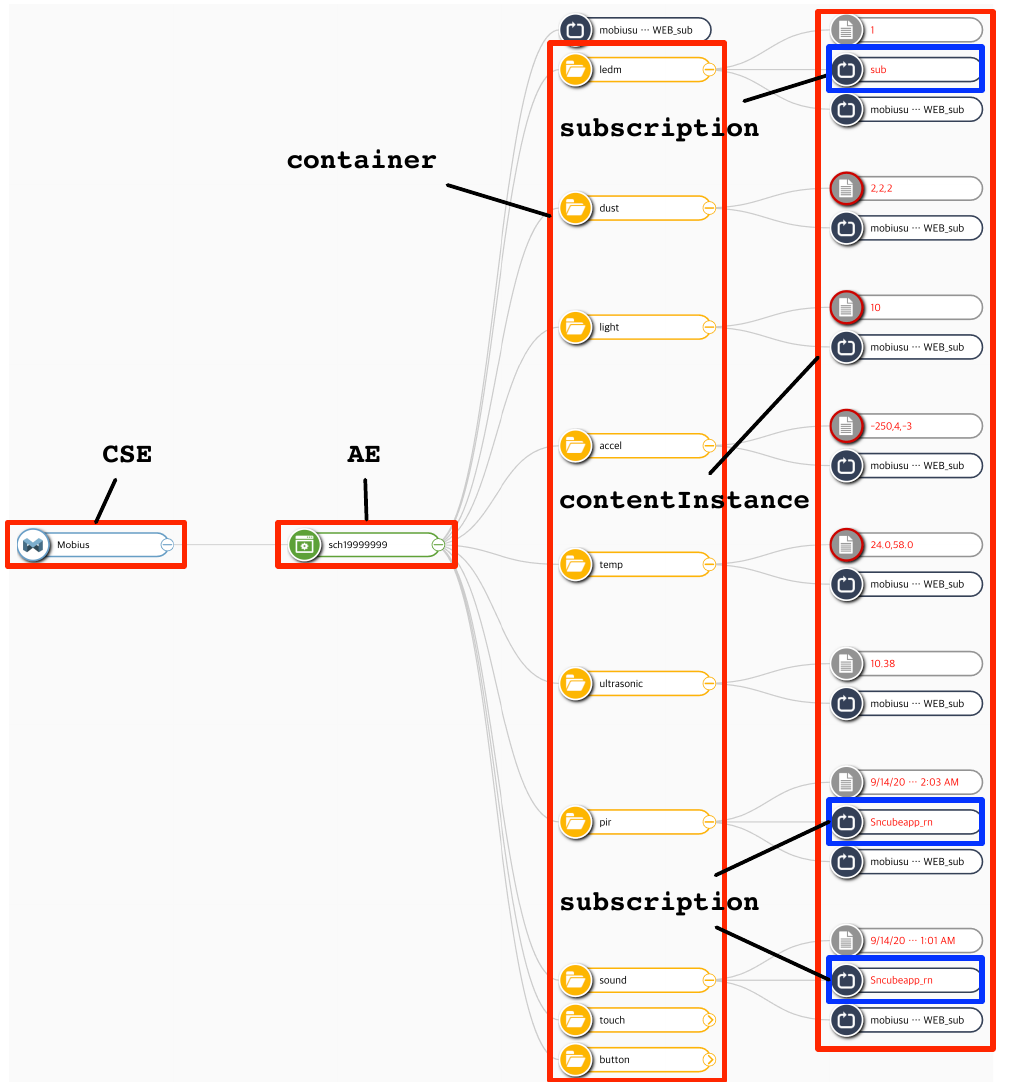
Figure 6. A captured image of the oneM2M resource